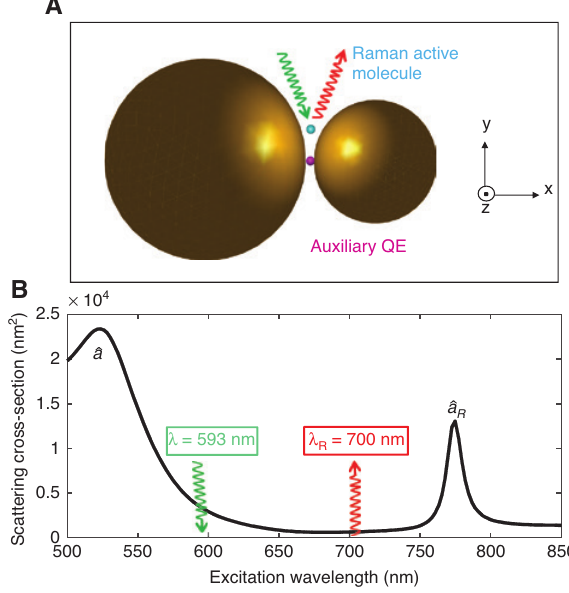
Figure 1: Enhancement of SERS signal with the help of an auxiliary QE. (A) The setup we consider for a double resonance scheme. A gold MNP dimer manifests two plasmon modes, depicted in (B). A Raman-active molecule (blue), placed close to the dimer gap, produces the Stokes signal. A QE (purple) is positioned in the a plasmon mode, into vicinity of the gap and interacts with the ˆ R which the Stokes signal emerges. (Details can be found in the text.) The presence of the QE does not change the intensity on the Raman- active molecule but enhances the Stokes